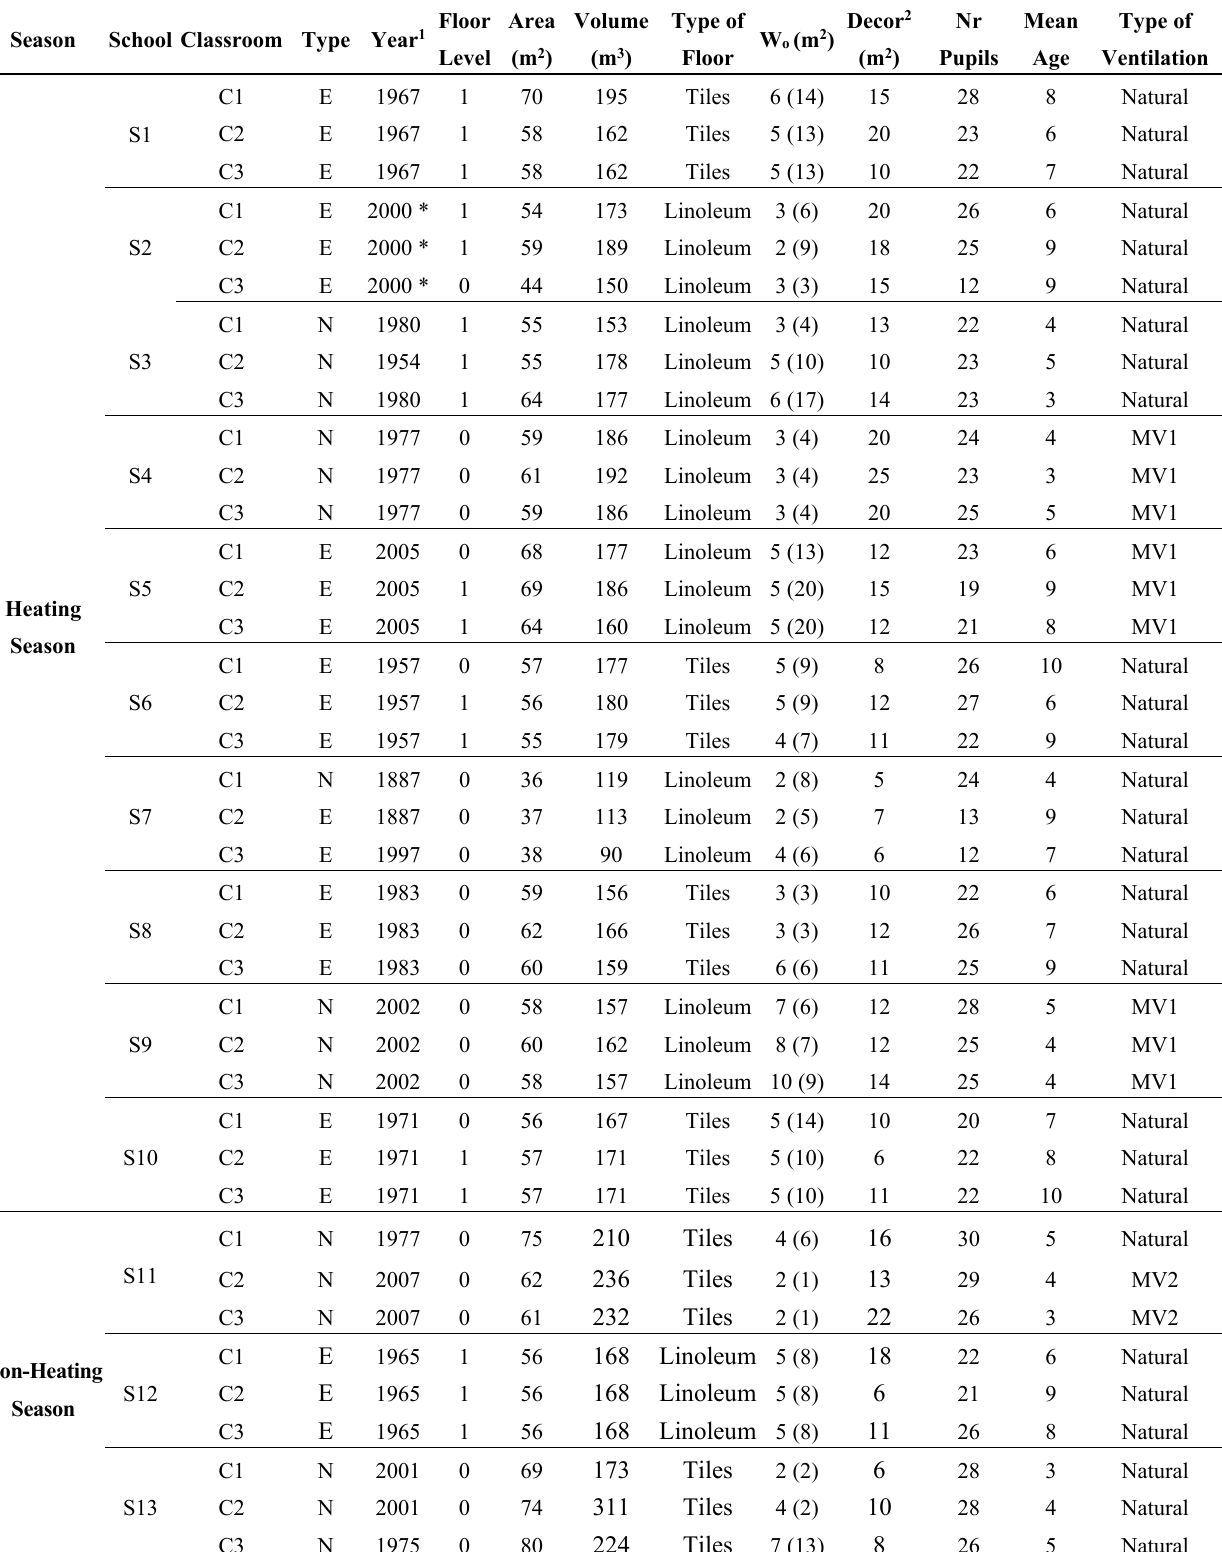
Table 1. Detailed information of the 30 classrooms monitored during the heating season (from 11 January to 2 April 2010) and of the 21 classrooms monitored during the non-heating season (from 26 April to 25 June